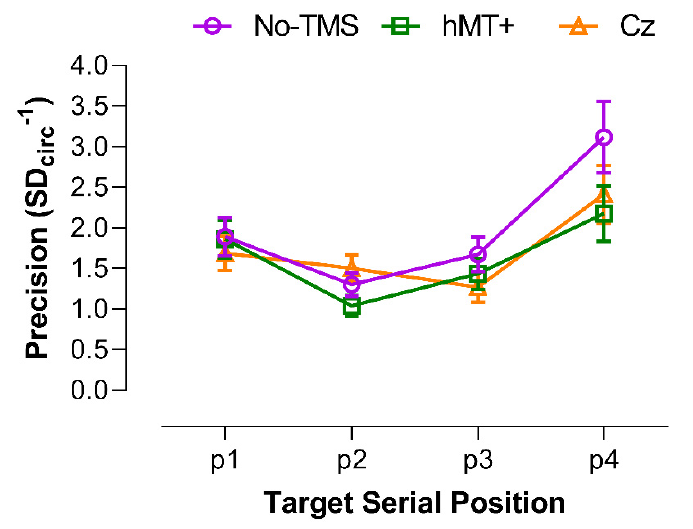
Figure 5. VSTM precision (calculated as the inverse of the circular standard deviation of the angular distance [error in radians] between the target direction and the participant’s response) for each stimulation type (different curves) as a function of the target serial position in the motion sequence. Error bars ±SEM.